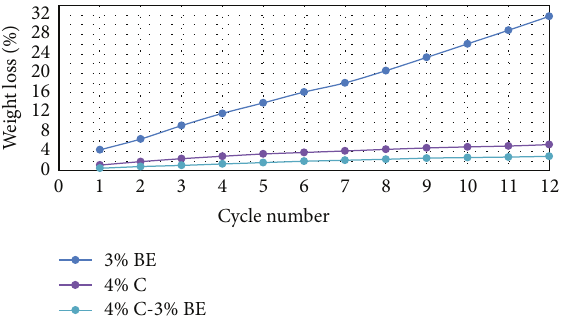
Figure 13: Total weight losses of BETB, CTB, and CBETB.